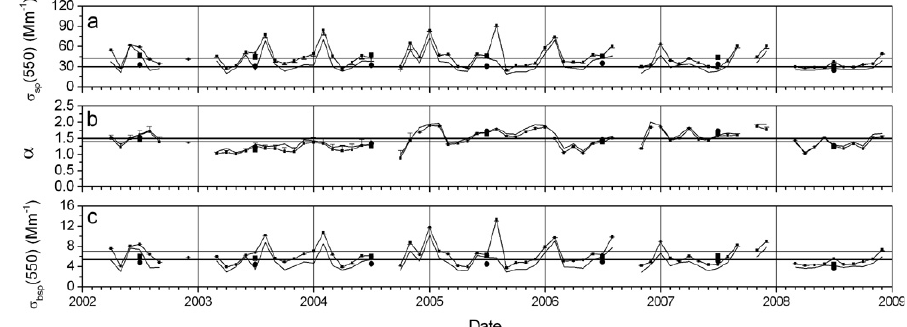
Fig. 2. Relative frequency distributions of (a) σ sp (550), (b) α and (c) σ sp (550) hourly values (N ∼ 47000 and bin size of 10Mm − 1 , 0.2 and 1Mm − 1 , respectively). Values of σ sp (550) > 250Mm − 1 and σ bsp (550) > 25Mm − 1 (less than 100 hourly values) are not shown for better resolution.